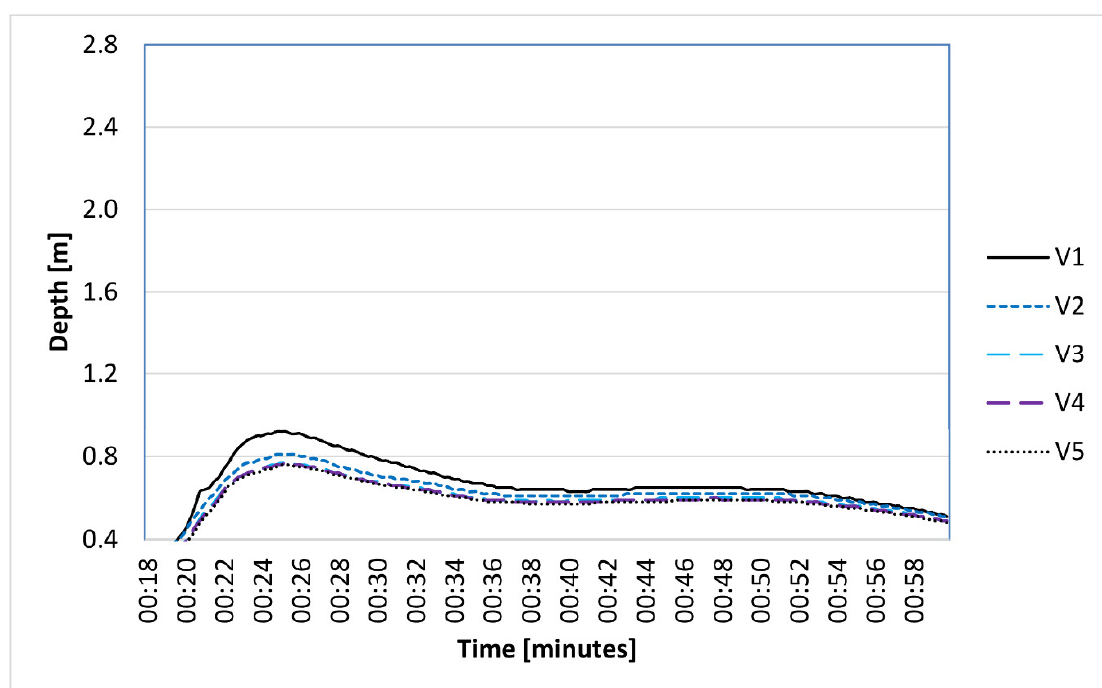
Figure 12. Change in flow rate in Link 30 canal—F = 5 years.